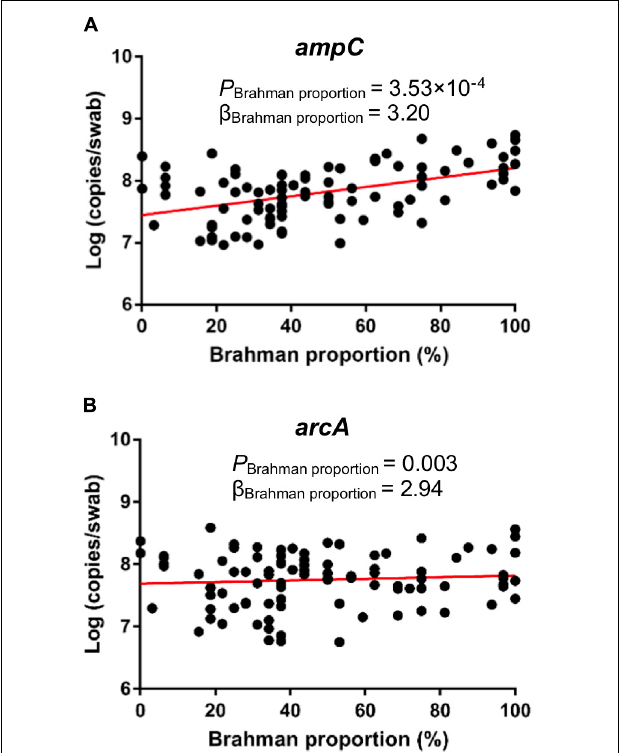
FIGURE 7 | Associations between breed composition and the concentration of ARGs detected by qPCR. Brahman proportion is significantly positively associated with copy numbers of ampC gene (A) and arcA gene (B) per swab.